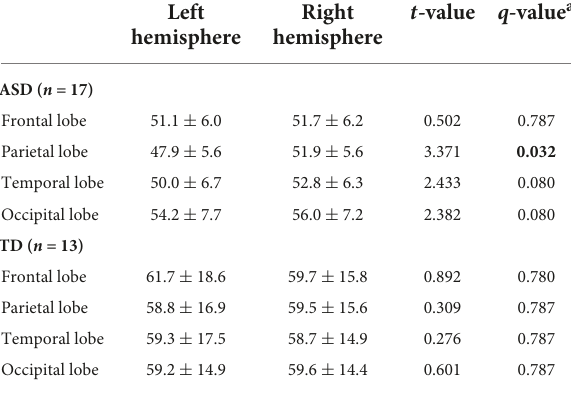
TABLE 2 Comparison of CBF between homologous regions in the two